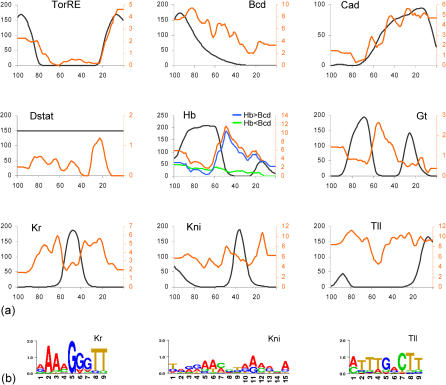
Ap Distribution of Binding Sites and Cognate Input Factors(A) Plots depict distribution of input factors (black) along the ap axis (anterior tip = 100, posterior tip = 0) (based on Myasnikova et al. [2001]) and the average number of binding sites (as measured by integrated profile values; Figure 4) found in all modules driving expression at a given percent EL (red) (see Materials and Methods). For TorRE, Bcd, and Cad, the distributions of binding sites and input factors are positively correlated. For Hb, Gt, and Kr, the distributions are negatively correlated; note that the number of binding sites is particularly high in modules expressed adjacent to the expression domain of these factors. In the case of Hb, modules with more Hb sites than Bcd sites (blue) show negative correlation with input factor distribution, and modules with fewer Hb sites than Bcd sites (green) show positive correlation, indicating bimodal function of Hb. For Kni and Tll, no clear correlations are found, possibly because of the unspecificity of their weight matrices.(B) Information scores of the Kr, Kni, and Tll weight matrices.